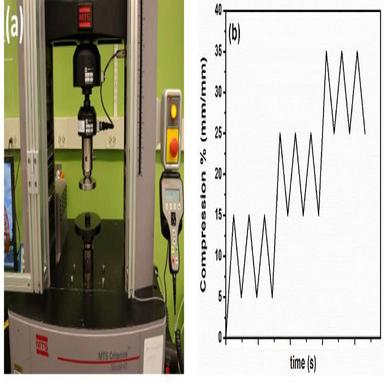
(a) MTS Criterion C43 universal testing machine and (b) Experimental compressive cyclic path.